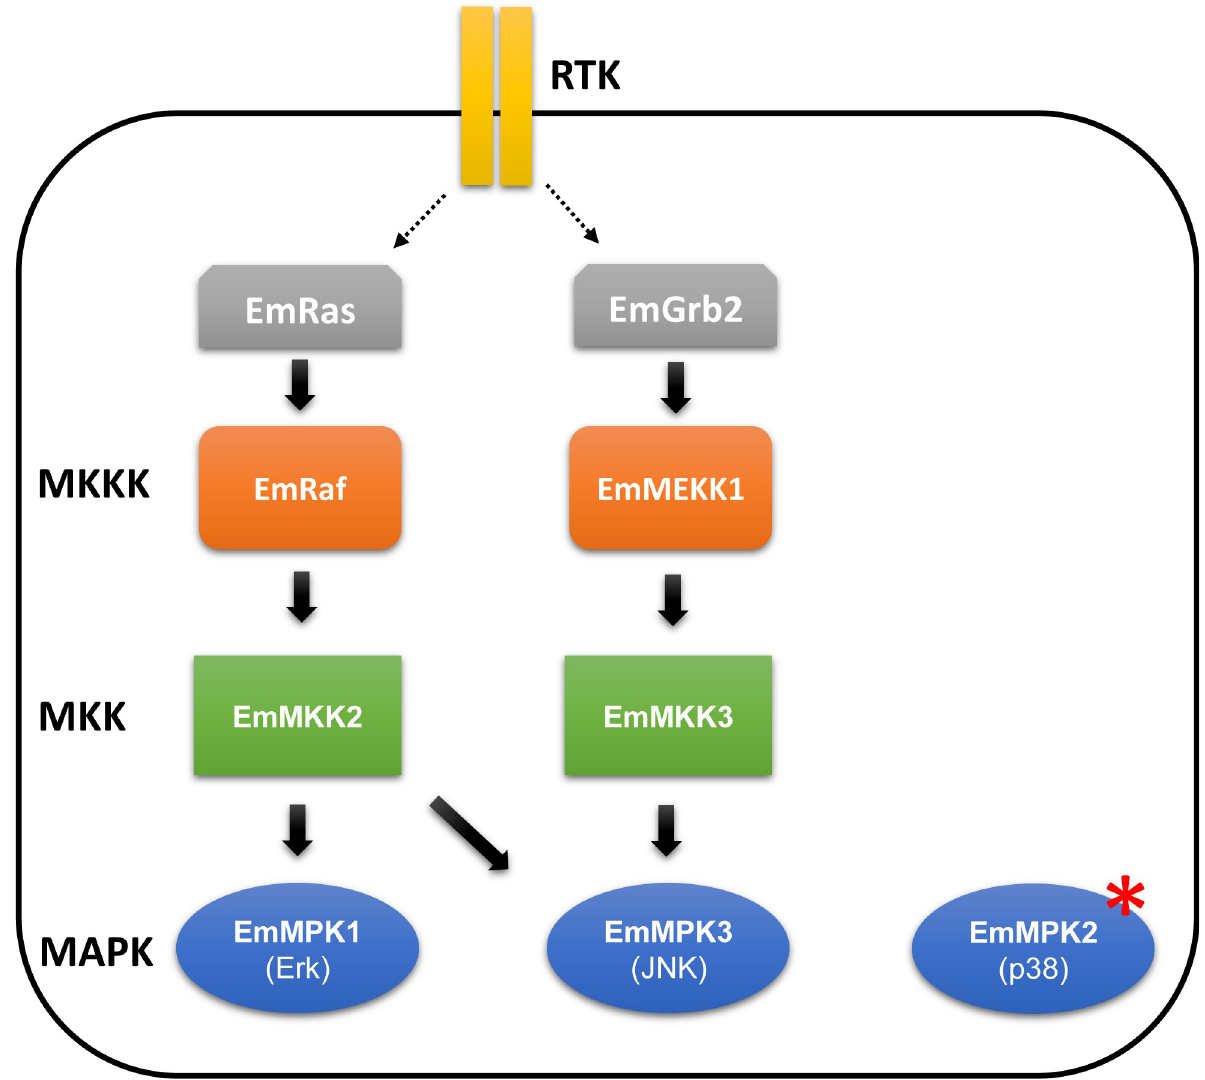
Fig 8. Model for MAPK cascade interactions in E . multilocularis . Depicted are E . multilocularis MAPK, MAPKK (MKK), and MAPKKK (MKKK) as well es upstream regulatory factors identified in this work and previous studies [14–17].Interactions which are verified by Y2H analyses are shown as solid black arrows, those which are presumed are indicated by dotted black arrows. Red asterix indicates that EmMPK2 is a constitutively active MAPK [17]. RTK, receptor tyrosine kinase.